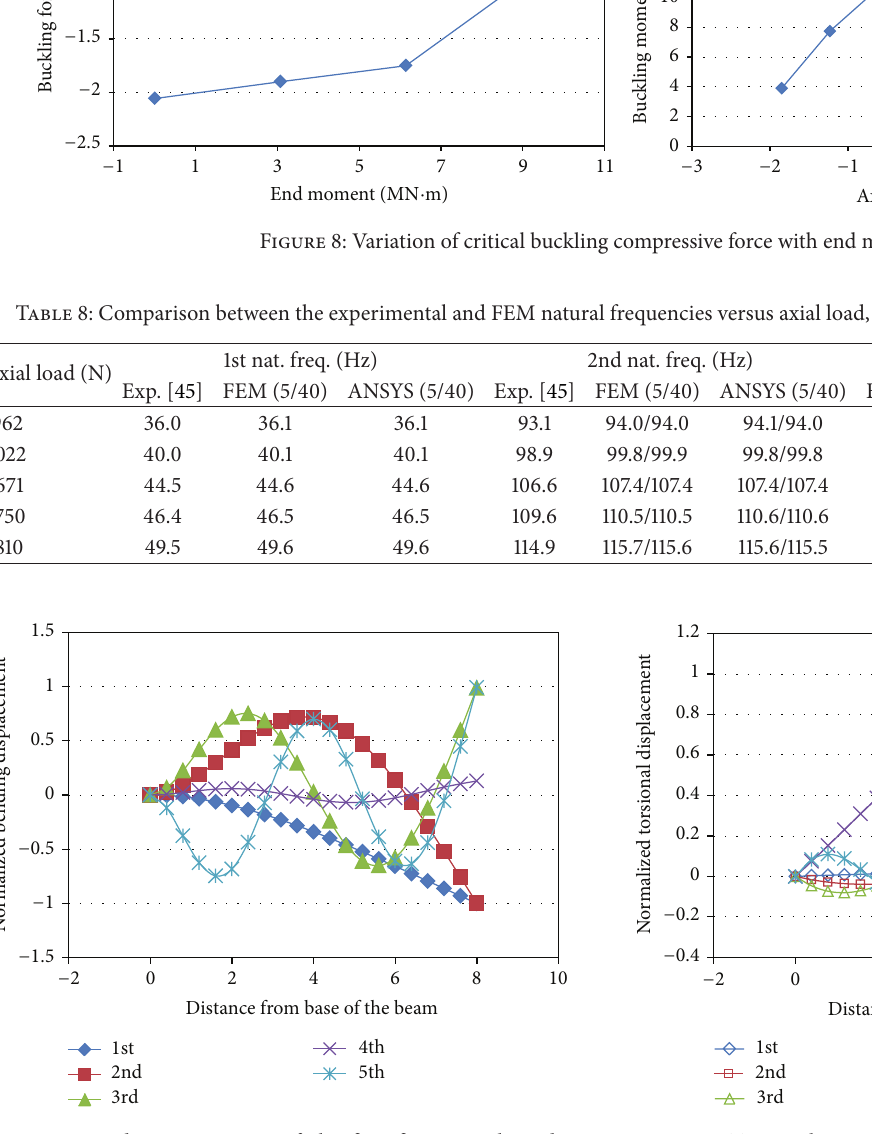
Figure 10: Torsional components of the first five natural modes; preloaded cantilevered